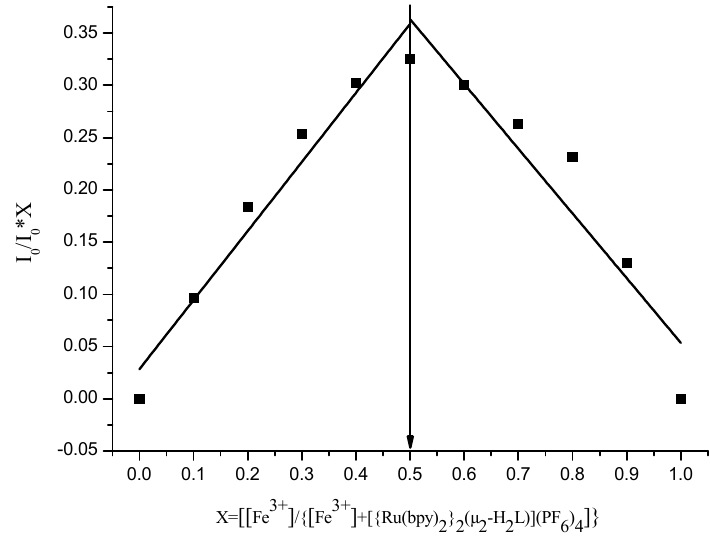
Figure 10. Jobs plot in CH 3 CN / H 2 O ( v / v , 1:1) of the complex [{Ru(bpy) 2 } 2 ( µ 2 -H 2 L)] 4 + and Fe 3 + binding.